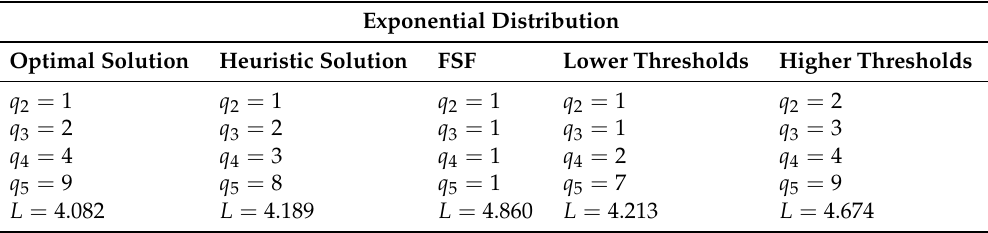
Table 5. Simulation results for the M / M /5 queueing system.